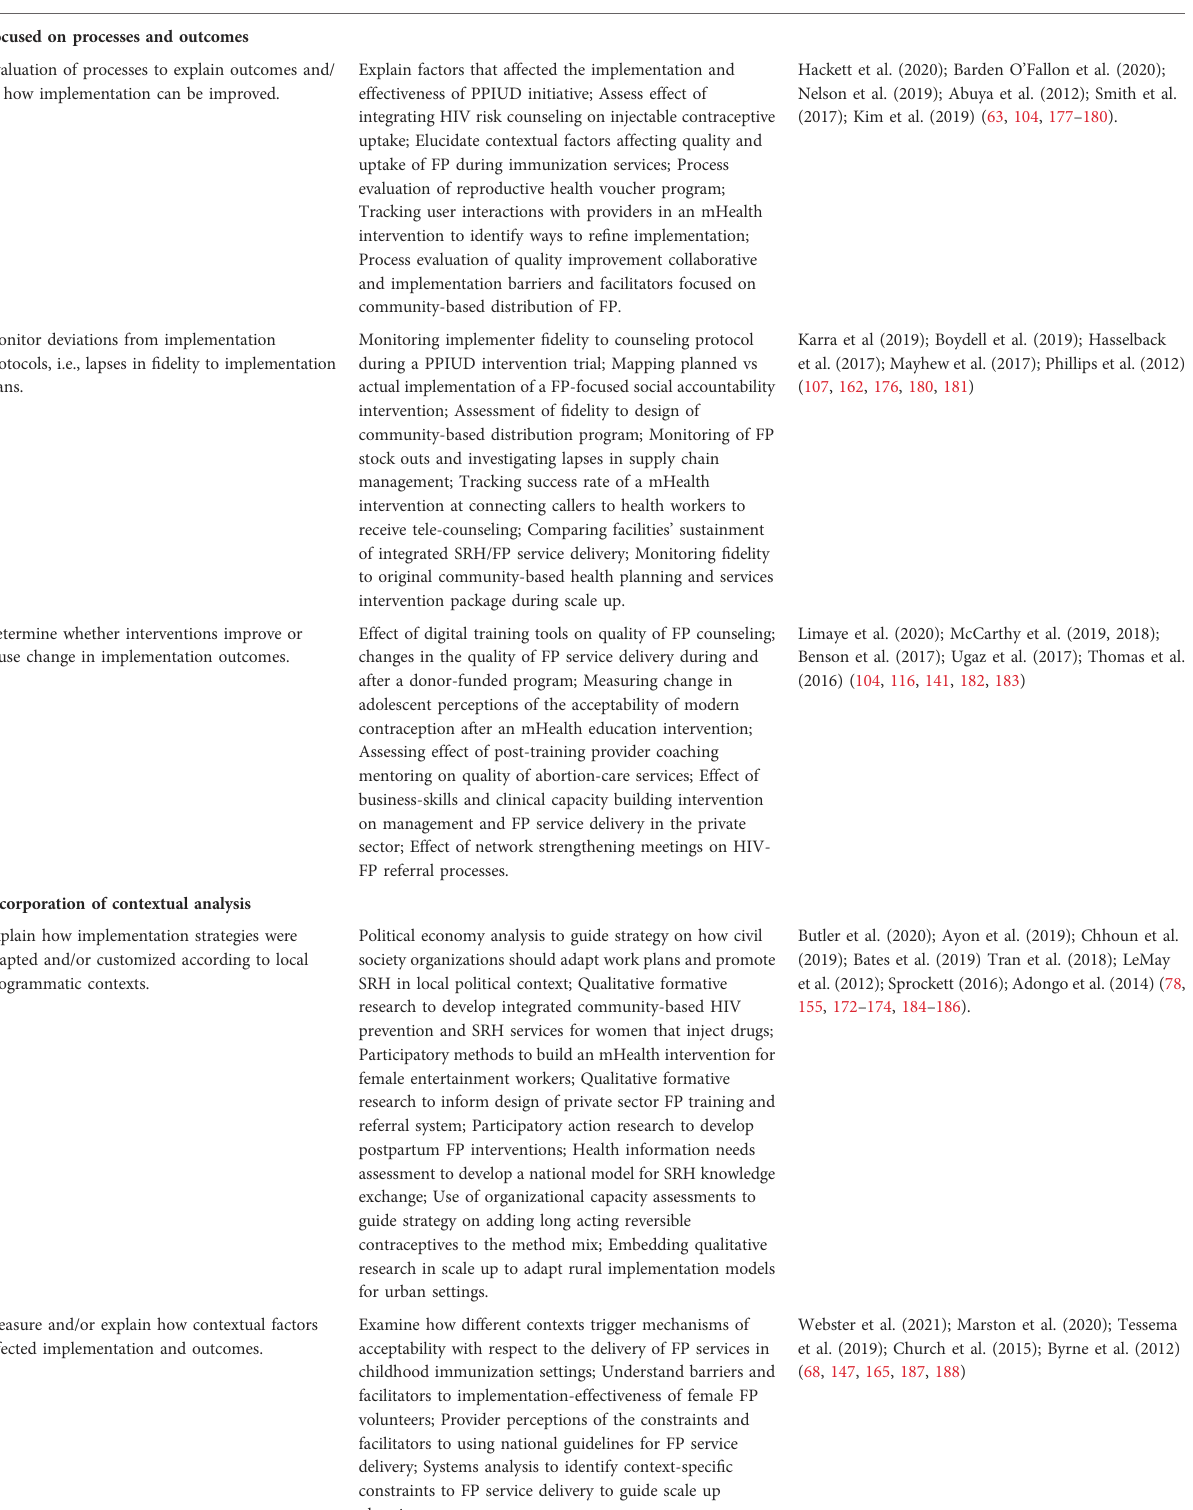
TABLE 5 In-depth review of iS studies with more complete reporting of salient iS